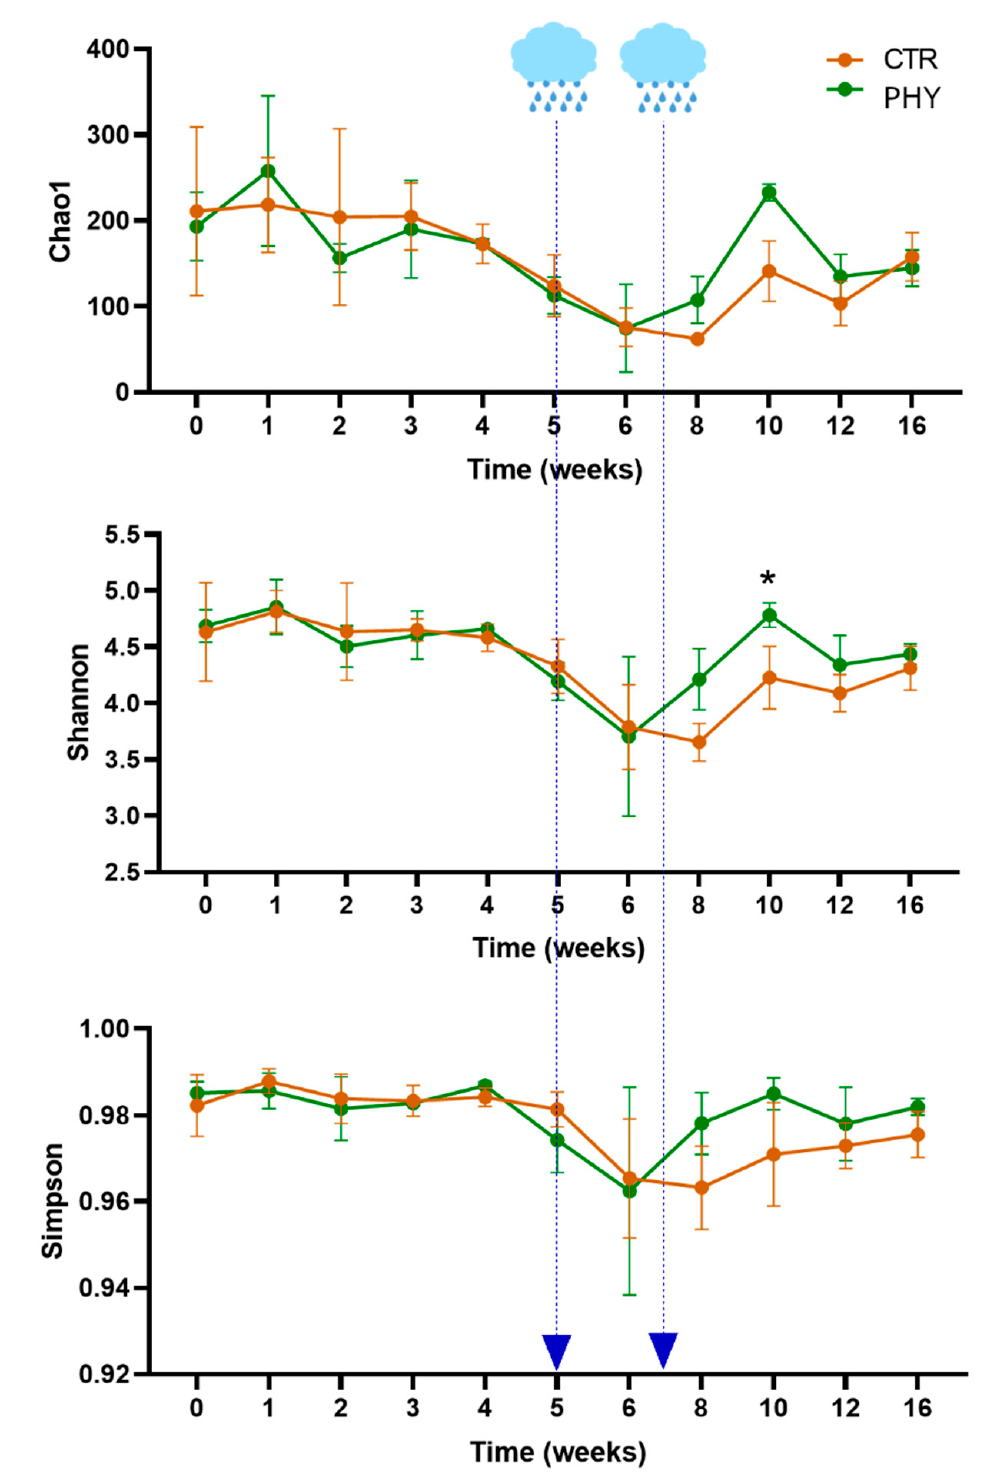
Figure 2. The temporal plot of alpha diversity indexes. The arrows point to the two significant rain events in weeks five and seven. The asterisk indicates a significant ( p = 0.04) difference in the Shannon diversity index at week 10.